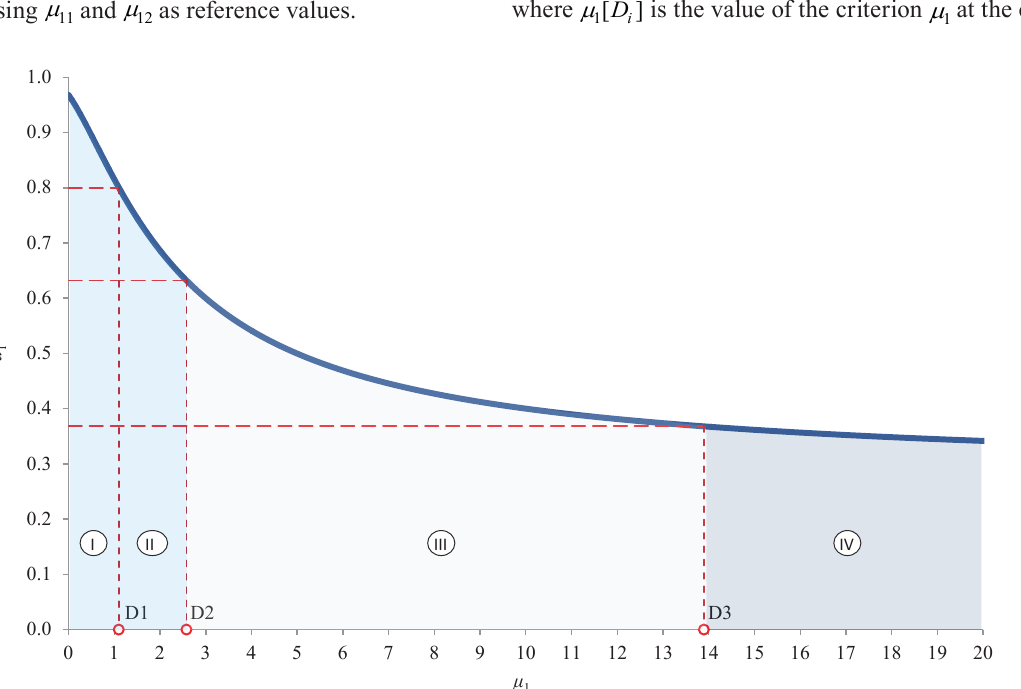
Cond and variable 1 µ 1 d